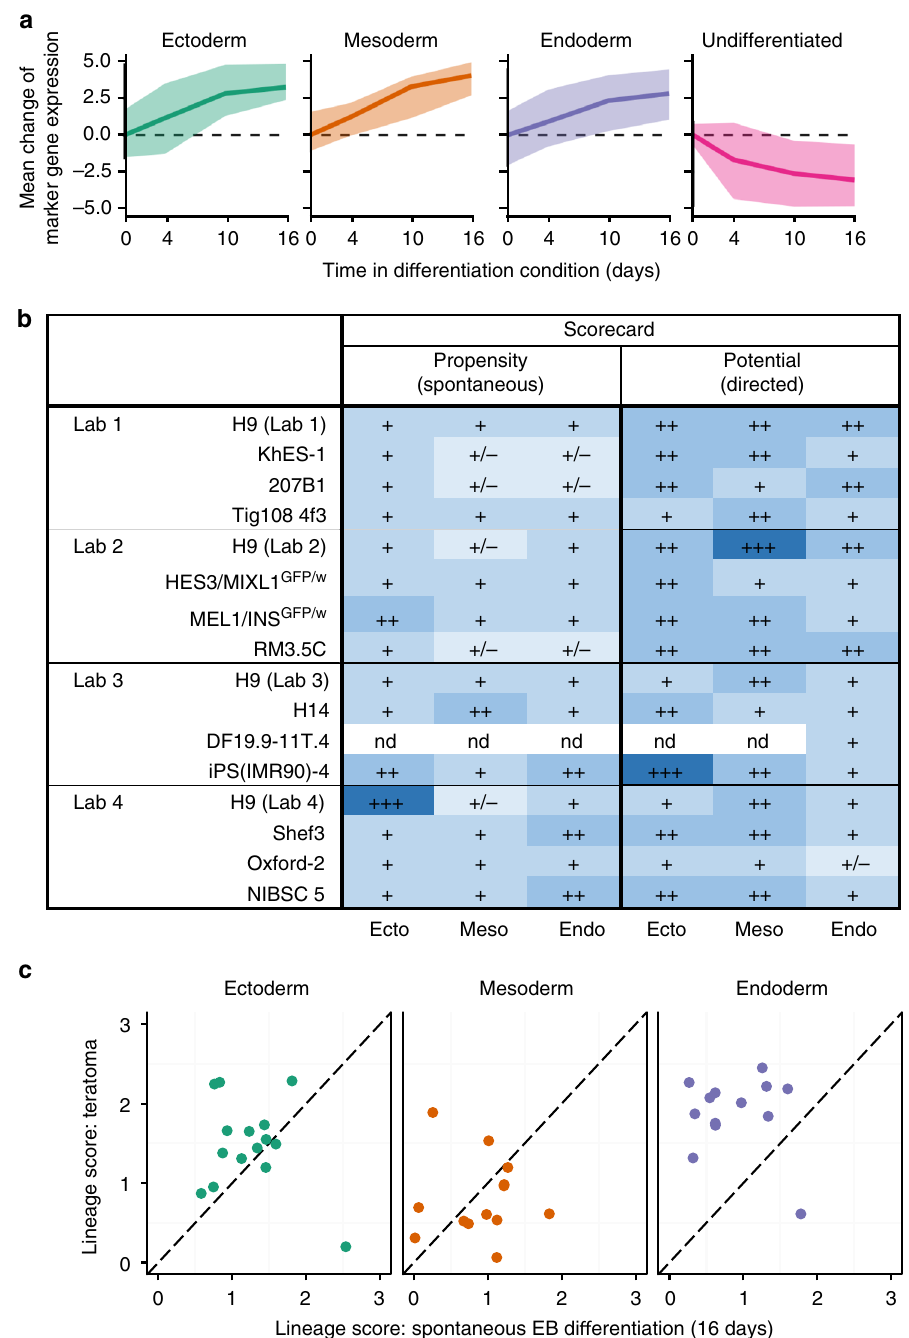
Lineage score: spontaneous EB di ff erentiation (16 days) Fig. 3 Differentiation potential and propensity in EBs. a The line plots show the mean log 2 expression change (relative to day 0) of marker genes (Supplementary table 3) as a function of time and averaged over all cell lines. The expression change is shown under ectoderm conditions for ectoderm markers, mesoderm conditions for mesoderm markers, endoderm conditions for endoderm markers, and across all conditions for markers of undifferentiated cells. Shaded contours indicate the minimum/maximum observed value. b A summary table of the lineage scorecard evaluation of the “ propensity ” (spontaneous differentiation, left) and “ potential ” (directed differentiation, right) for each cell line (rows) to differentiate into the respective lineage (columns). Colors and symbols indicate increased (blue) and limited (grading of lighter blues) preference for expression of lineage- speci fi c marker genes. +++ : score >3; ++ : score 2 – 3; + : score 1 – 2; + / − : score <1. nd not analyzed due to RNA failing quality control criteria. c Scatterplots contrasting the lineage score after 16 days of EB differentiation ( “ propensity ” ; x -axis) with the lineage score for teratomas derived from the same cell lines ( y -axis). The lineage scores for ectoderm (left), mesoderm (center), and endoderm (right) marker expression are shown